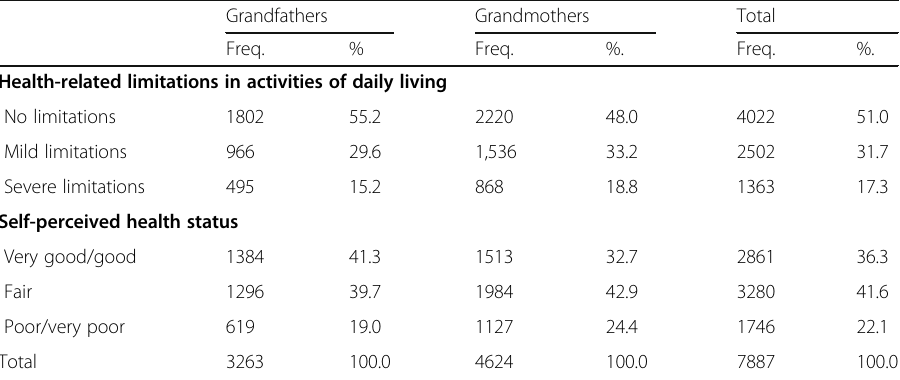
Table 1 Grandparents aged 60 years or more with health-related limitations in the activities of daily living and self-perceived health status